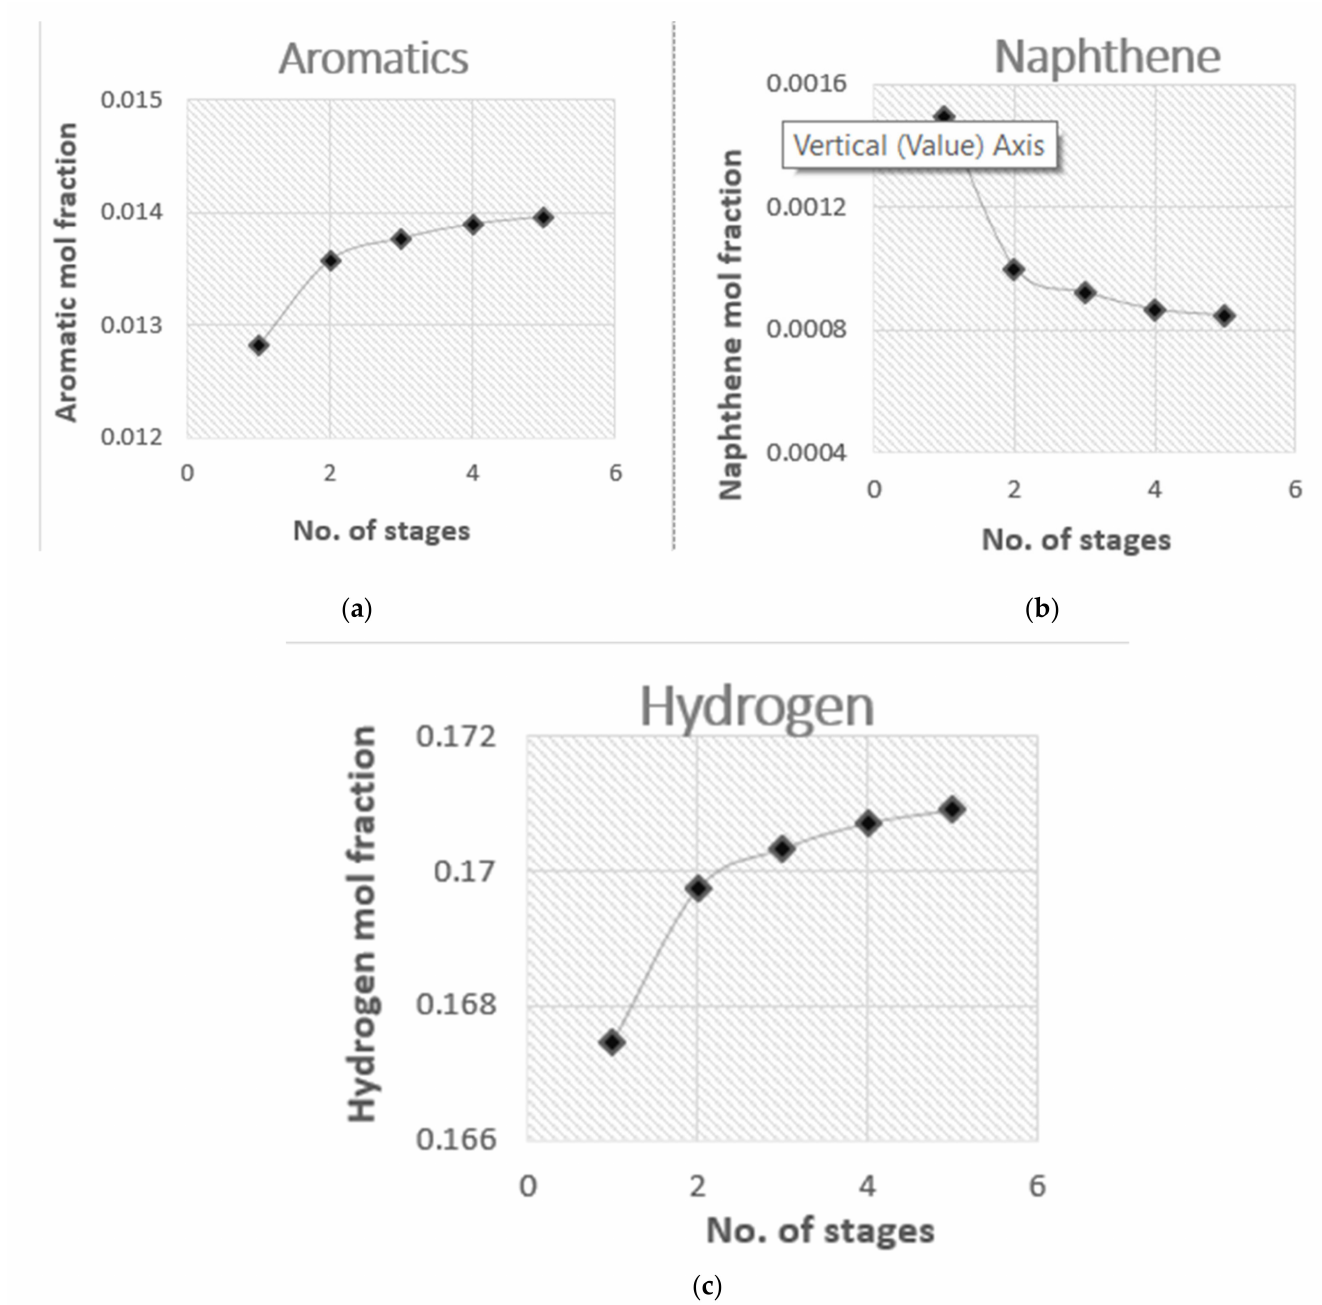
Figure 5. Effect of the number of stages on FBMR for ( a ) aromatics; ( b ) naphthene; ( c )